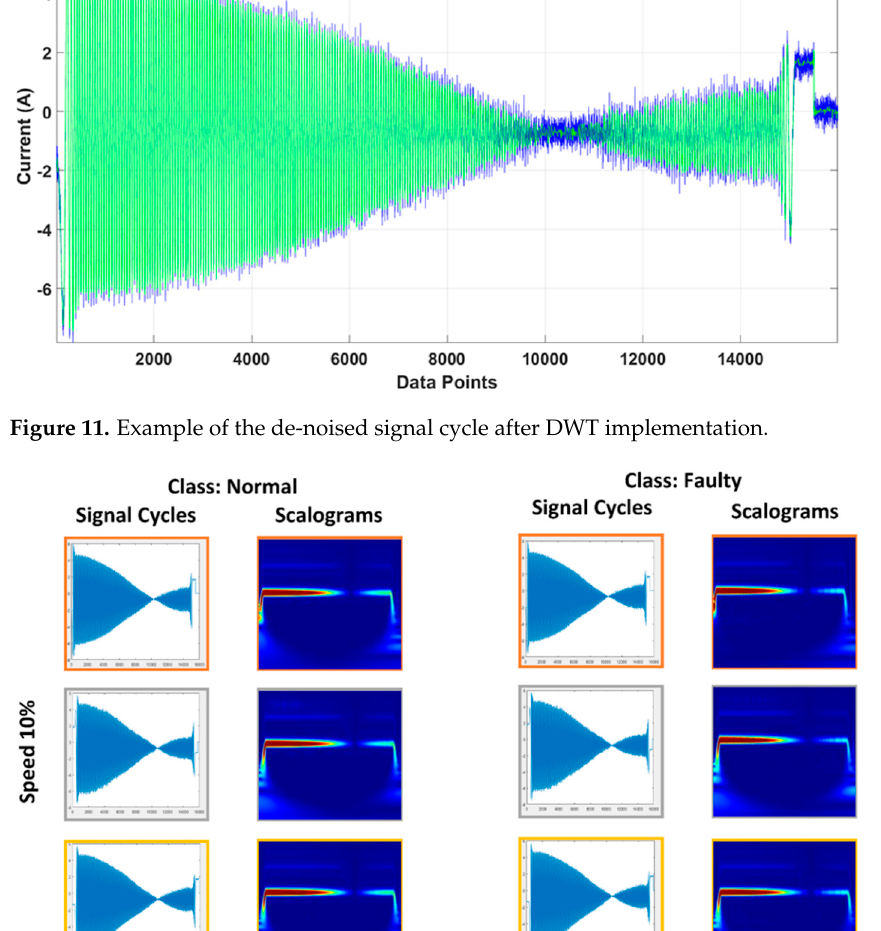
Figure 12. Scalogram images after CWT implementation for a single domain of 10% rotation speed. Original ISMD Data